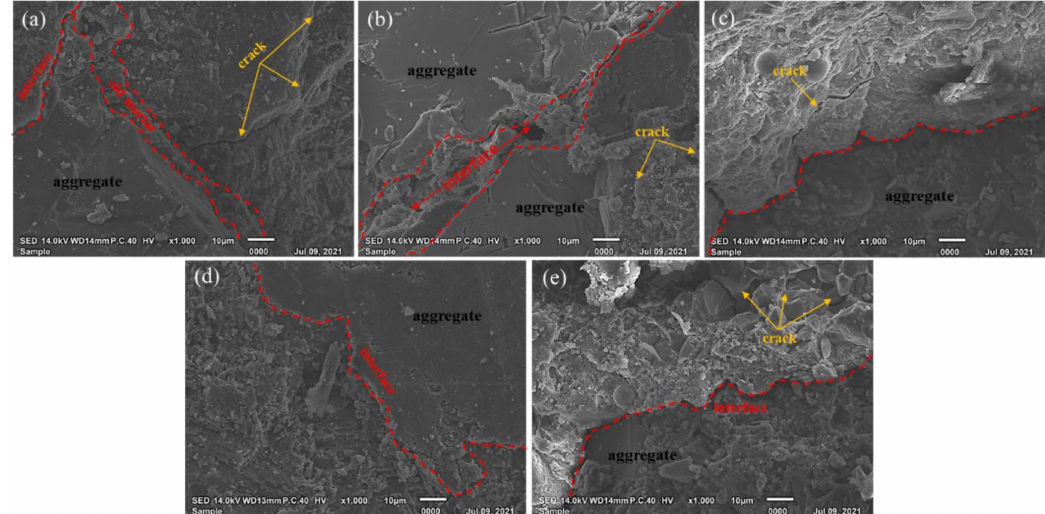
Figure 11. SEM images of RAC and MSRAC with medium– and low–quality MS before the RCM test: ( a ) RAC; ( b ) MS2–50; ( c ) MS2–100; ( d ) MS3–25; ( e )